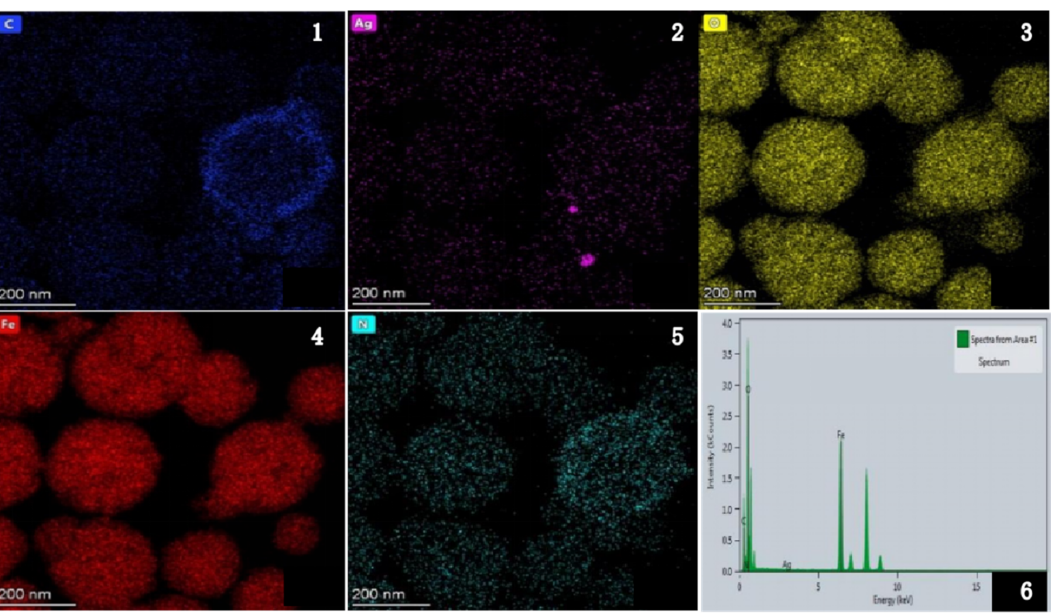
Figure 3. TEM mapping and EDS of Fe 3 O 4 @PDA@Ag@GO nanocomposites. ( 1 ) The elemental mappings of C; ( 2 ) the elemental mappings of Ag; ( 3 ) the elemental mappings of O; ( 4 ) the elemental mappings of Fe; ( 5 ) the elemental mappings of N; ( 6 ) EDS of Fe 3 O 4 @PDA/Ag/GO.